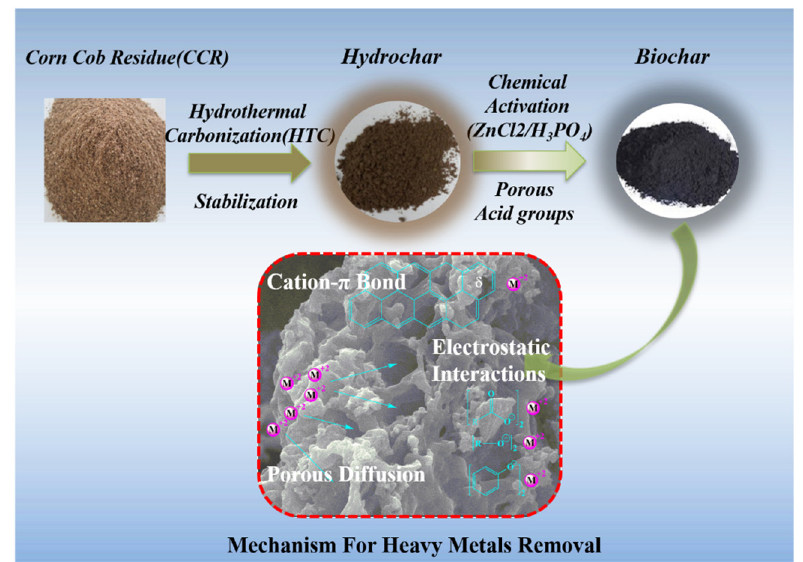
Figure 2. Concept of Biochars preparation and their applications for heavy metal ion removal through adsorption mechanisms.